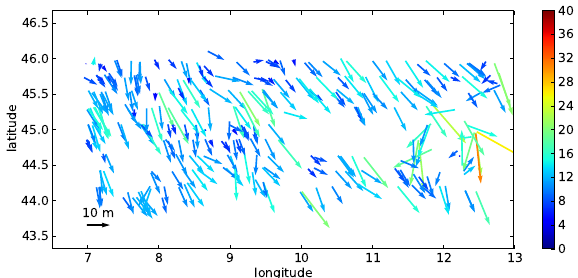
Figure 3: Mean errors of the Euro-Maps 2D checkpoints after single stereo pair alignment. Each arrow represents the mean X and Y error of a stereo pair. 101 stereo pairs were located in very flat areas and could not be oriented using DSM alignment.